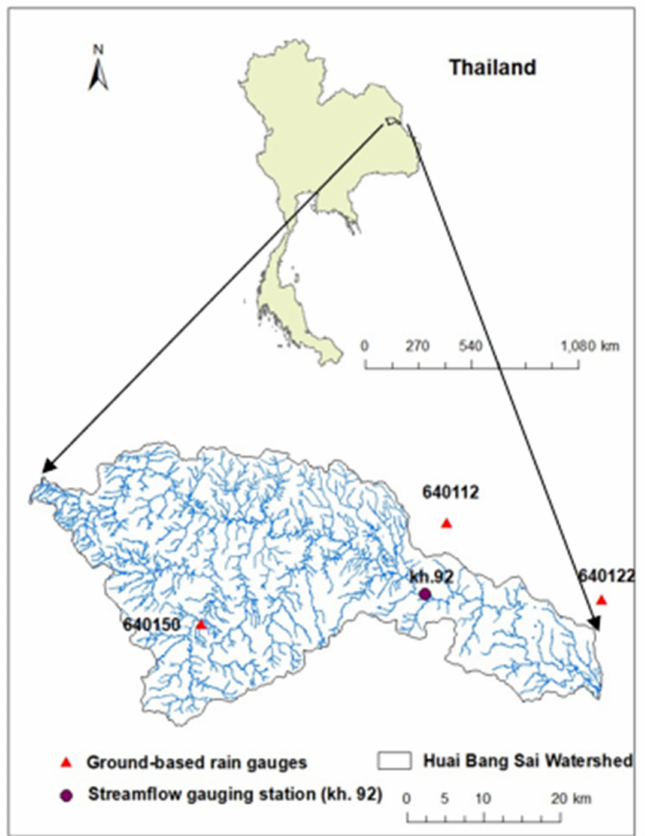
Figure 1. Hydro-meteorological network and stream network in the HBS